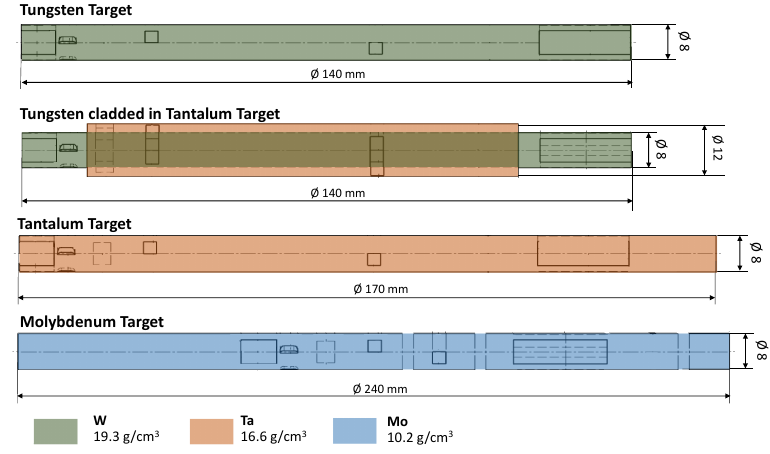
Figure 7. Geometry of the HiRadMat-27 targets [17] inspected by neutron imaging in the session of 2017.